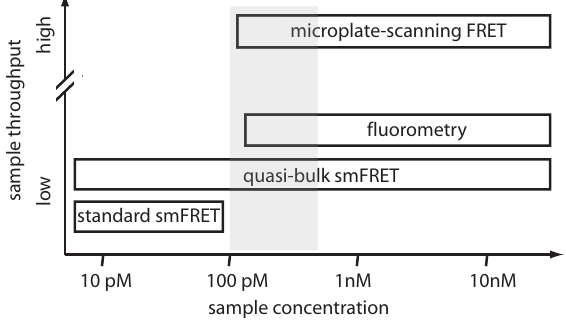
Figure 7. Operational regime of different FRET methods. Conventional smFRET and fluorometric assays are difficult to perform in the intermediate concentration regime (100 pM to 1 nM, shaded area). Quasi-bulk smFRET and microplate-scanning FRET ( m psFRET), on the contrary, allow us to accurately determine FRET efficiencies in this regime and effectively close the gap between single molecule and ensemble FRET spectroscopy. A large range of sample concentrations is now amenable to fast, high throughput estimation of bulk